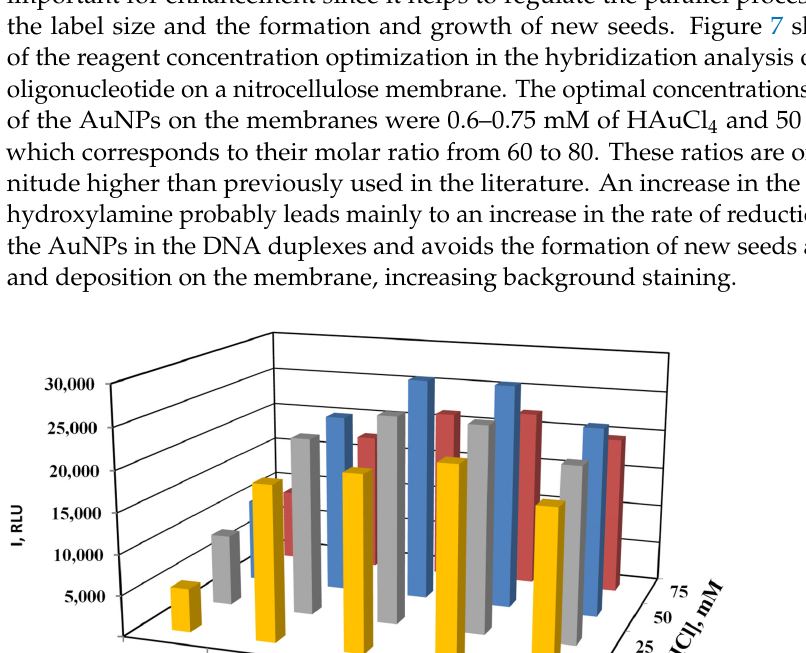
Figure 8. Images of nitrocellulose microarrays before and after the enhancement of AuNP labels using an enhancement solution at optimized reagent concentrations and pH (0.7 mM tetrachloroau- ric acid and 50 mM hydroxylamine, pH 3.5) ( a ); the staining intensities of specific (blue) and back- ground (gray) spots with different orders of reagent mixing ( b ); and signal-to-noise ratios with dif- ferent orders of reagent mixing ( c ). Target oligonucleotide (50 pM) was hybridized on the microar- rays. 1 —the pH value of tetrachloroauric acid solution was adjusted to 3.5 before the mixing with hydroxylamine; 2—the reagents were mixed without adjusting the pH value.